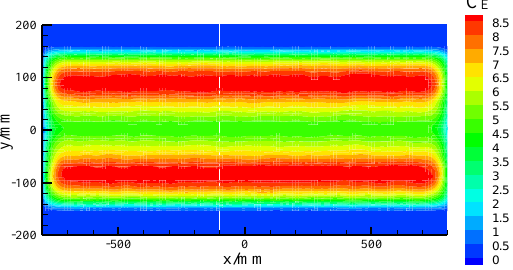
Figure 14. 2-D heat flux distribution when k = 0.9.